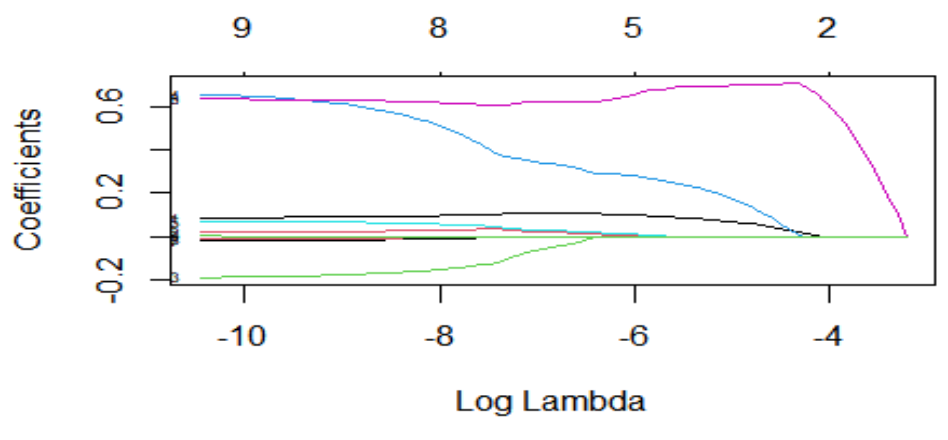
Figure 3. BIC scores.